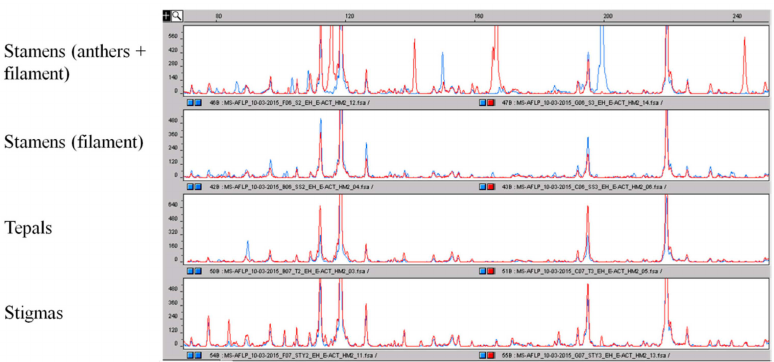
Figure 7. Comparison of the epigenetic profile obtained by using the MS-AFLP markers of the different parts of the crocus flower. As for AFLP, the different peaks correspond to DNA fragments of different sizes. It is clearly visible that the epigenetic profile of the whole stamens is very different with respect to the epigenetic profile of filaments and other parts of the flower that are more conserved. The polymorphisms among stamens and the other parts of the flower are